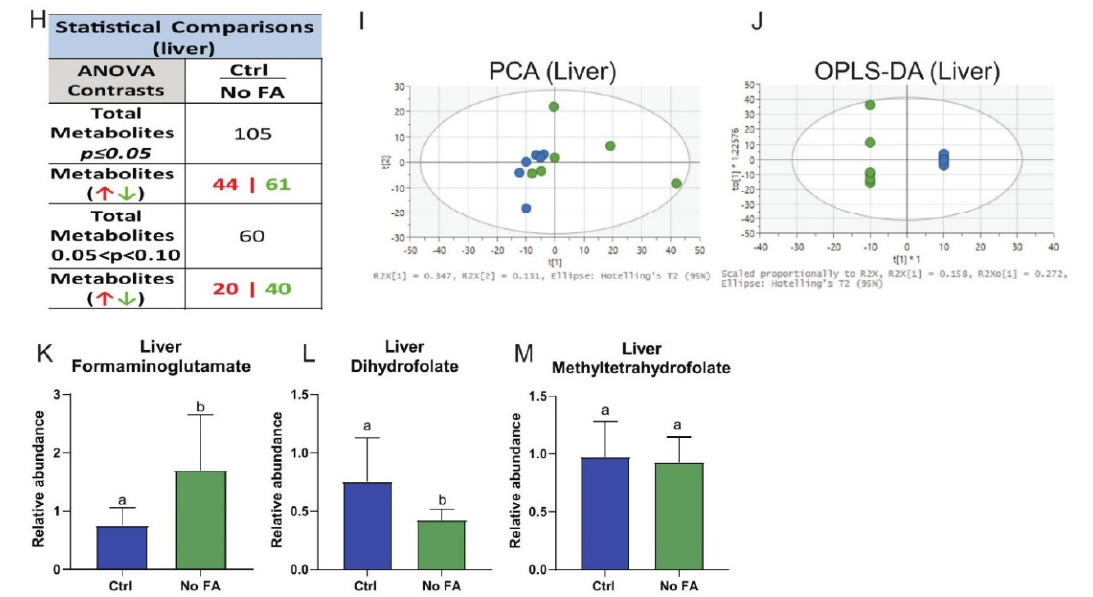
Figure 7. Dietary FA restriction enhances growth of orthotopically transplanted M-Wnt mammary tumors and minimally effects tumor metabolomic profile. Body weight of mice fed different folate diets for 3 weeks ( A ) (n = 10–14/group). Body composition determined by echo MRI ( B ) (n = 10–14/group). Ex vivo tumor volume ( C ) and weight ( D ) (n = 9–13/group). Summary of tumor metabolomics ( E ), PCA of tumor metabolomics ( F ) (n = 6/group). Tumor metabolite levels of 5-mTHF ( G ) (n = 6–7/group), different letters indicate significant differences.